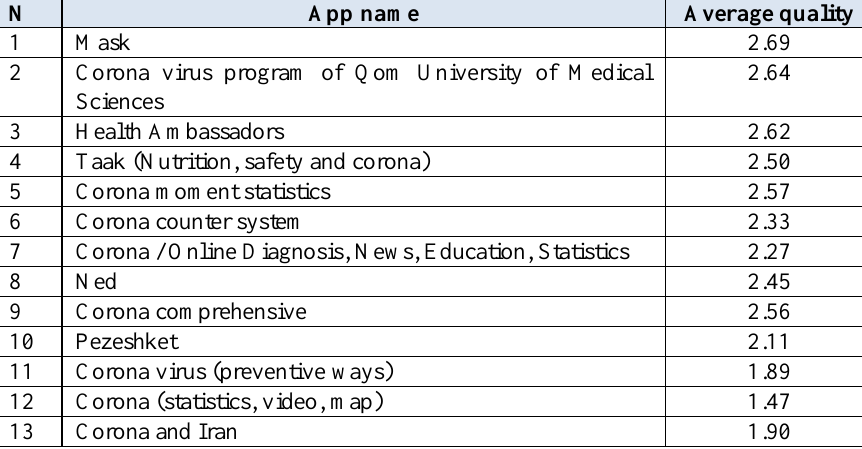
Table 2. Average score of quality of coronavirus applications